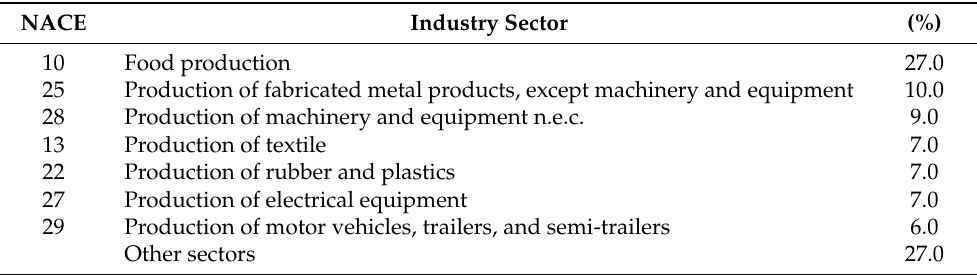
Table 2. Distribution of firms by industry